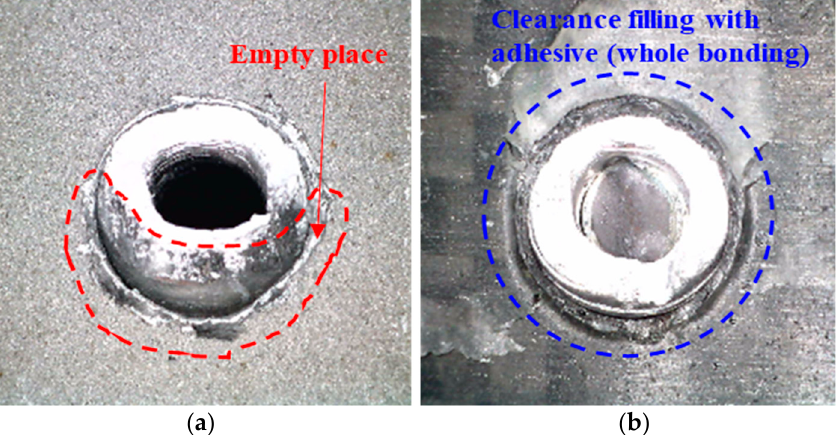
Figure 4. Fractured surface of LSS specimens depending on whether or not adhesive was used: ( a ) rivet only and ( b ) both rivet and adhesive .